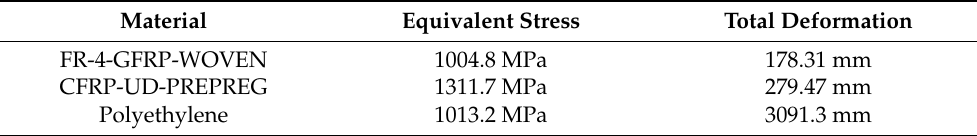
Table 3. Comparative structural outcomes under forward speed manoeuvring.